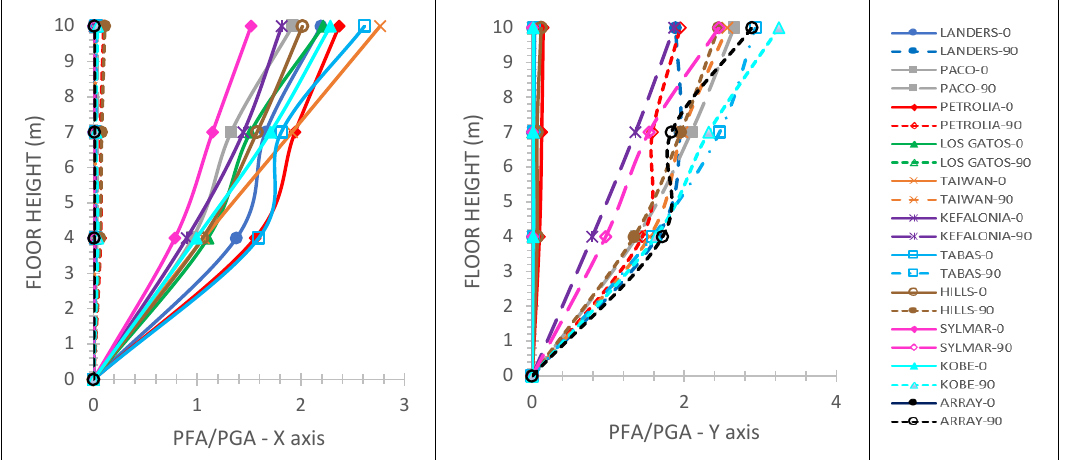
Figure 9. PFA/PGA along X ( left ) and Y ( right ) horizontal directions of the three-story mixed building, considering the fixed connection of the steel structure to the r/c one.